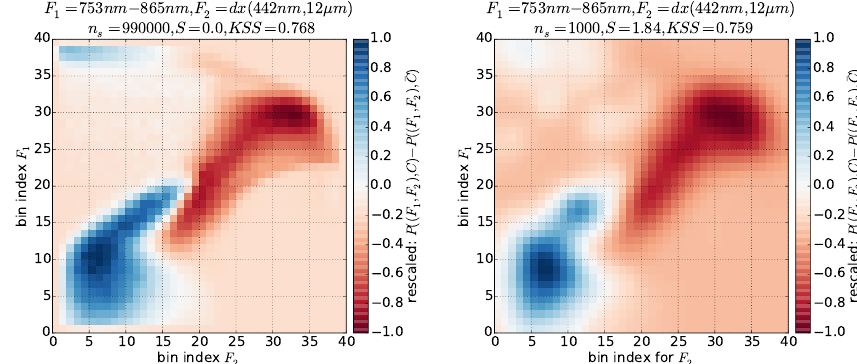
Figure 3. Difference of the two-dimensional histograms for P( F ,C) and P( F , ¯ C) . The left panel show a direct results using 990000 globally distributed measurements, while for the right panel only 1000 measurements were used. The histograms on the right side were post-processed using Gaussian smoothing with a width parameter of 1 . 84.